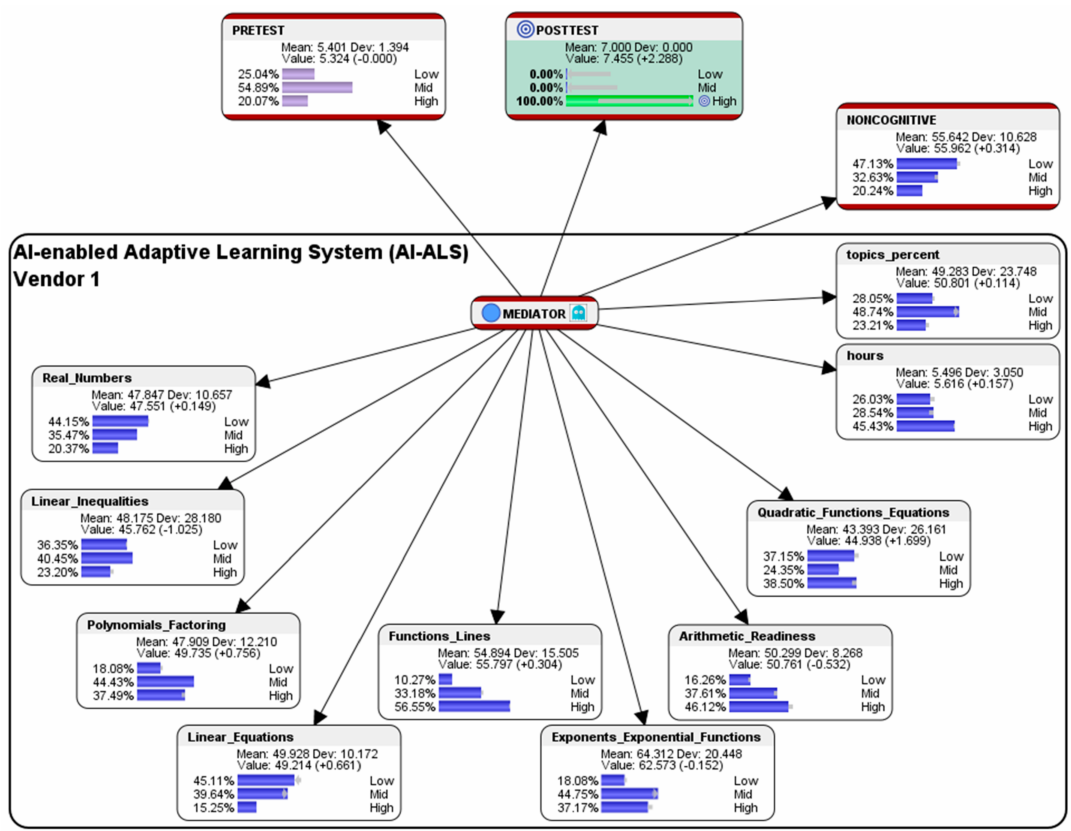
Figure 16. Simulation of counterfactual results for 100% of the students who had used Vendor 1 (cid:48) s AI-ALS to score at the high-level in the